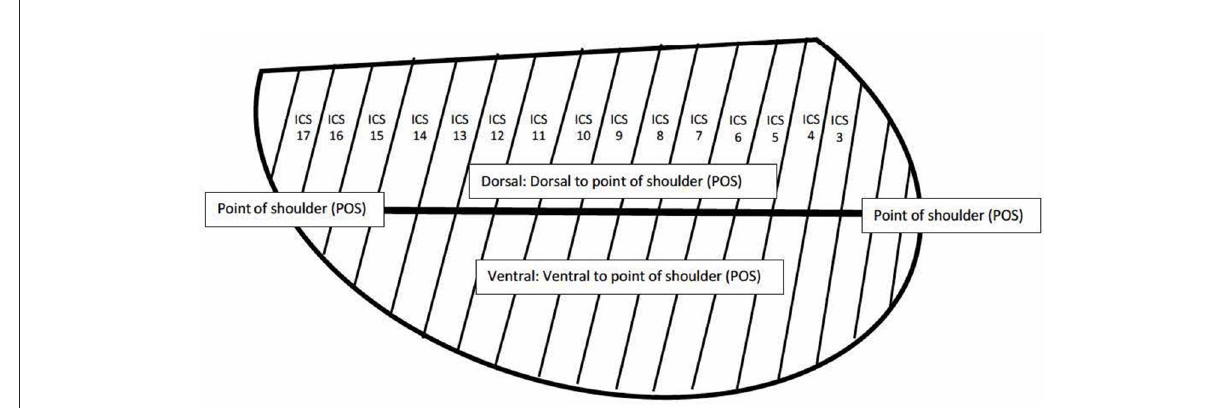
FIGURE1 Diagram depicting intercostal spaces and dorsal and ventral regions for LUS score.